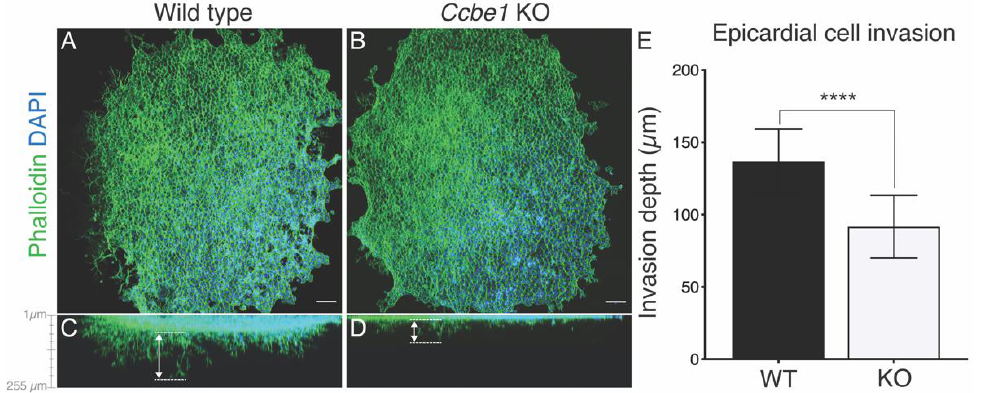
Figure 5. EPDC invasion is impairs in Ccbe1 KO epicardial explants. ( A , B ) x/y plane of epicardial outgrowths from wild-type ( A ) and Ccbe1 mutant ( B ) explants stained with phalloidin. ( C , D ) Confocal imaging of epicardial cell invasion along the z axis. Images are representative of the following number of replicates: wild-type, n = 11; mutant, n = 14. ( E ) Measurements along the z-axes showed a significant decrease in the depth of epicardial cell invasion in the Ccbe1 KO explants compared with wild-type. **** p < 0.0001. Differences were considered statistically significant when p < 0.05. Error bars represent SDs. S cale bars = 100 μm.